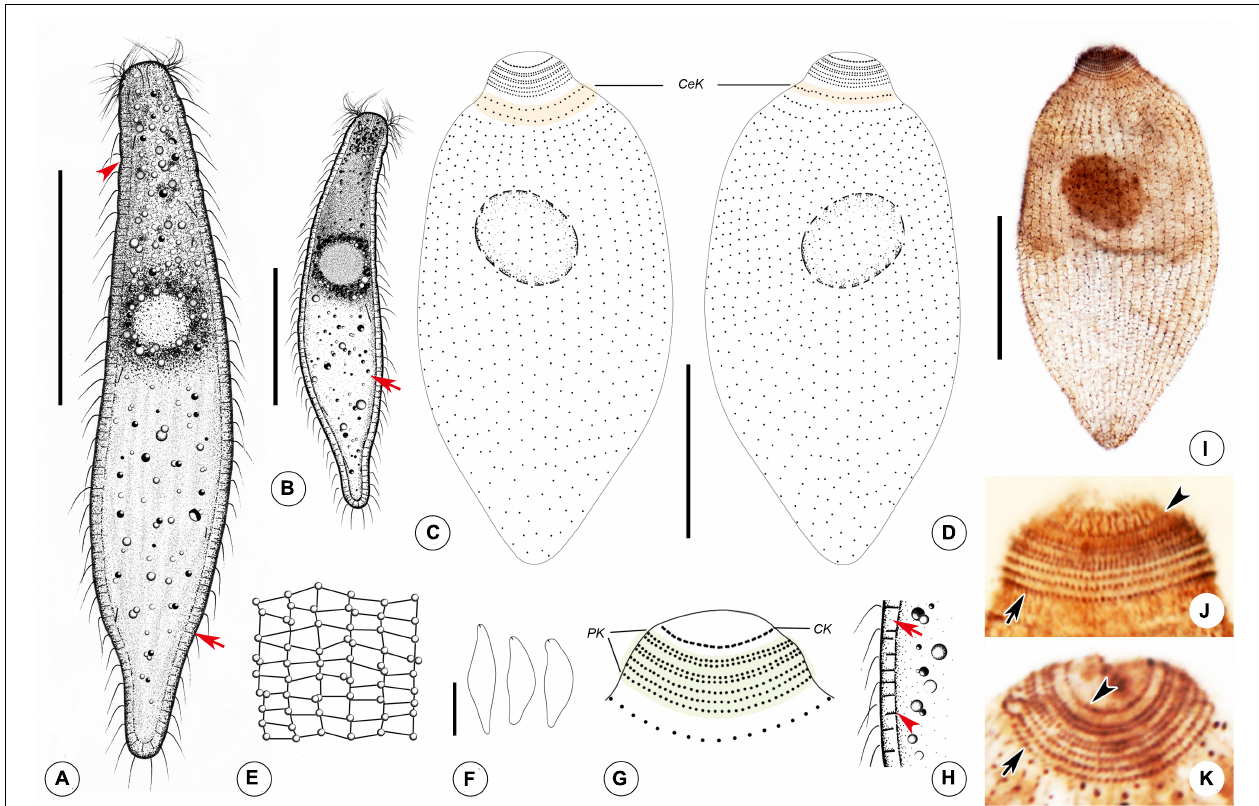
FIGURE 5 | Drawings (A–H) and photomicrographs (I–K) of Foissnerophrys alveolata gen. n., sp. n. in vivo (A,B,E,F,H) and after protargol staining (C,D,G,I,K) . (A) Lateral view of a representative individual, showing general appearance of body, cortical granules (arrow), and furrows in ectoplasm (arrowhead). (B) Different body shape, showing the flat posterior end of the body (arrow). (C,D) Side views of the holotype specimen, showing ciliary pattern of the cell and cervical kineties (CeK). (E) The distribution of cortical granules and pattern of silverline system. (F) Lateral view of a specimen showing its contractility. (G) Ciliary pattern of the anterior portion of the cell showing the circumoral kinety (CK) and perioral kineties (PK). (H) Portion of cortex, showing the hyaline ectoplasm (arrow) and cortical granules (arrowhead). (I) Lateral view of holotype specimen showing ciliary pattern and macronucleus. (J,K) Side view of anterior portion of the cell showing the circumoral kinety (arrowheads) and perioral kineties (arrows). CeK, cervical kineties; CK, circumoral kinety; PK, perioral kineties. Scale bars: 40 µ m (A–D,I) , 60 µ m (F)